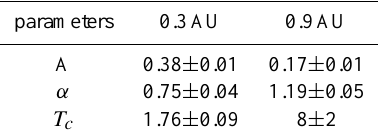
Fig. 4. Waiting-time distributions of B s for slow wind at different radial distances. The slope of the power law is indicated in the picture. The points are derived from an average of the histogram over logarithmically, equally spaced intervals and are normalized to the maximum value. Table 4. Parameters of the fit: slow